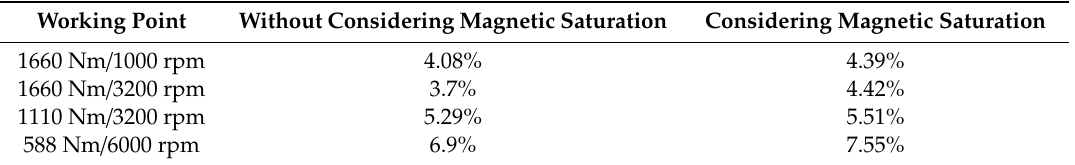
Table 2. The total harmonic distortion rate of the phase current of the motor with and without considering the magnetic saturation effect.